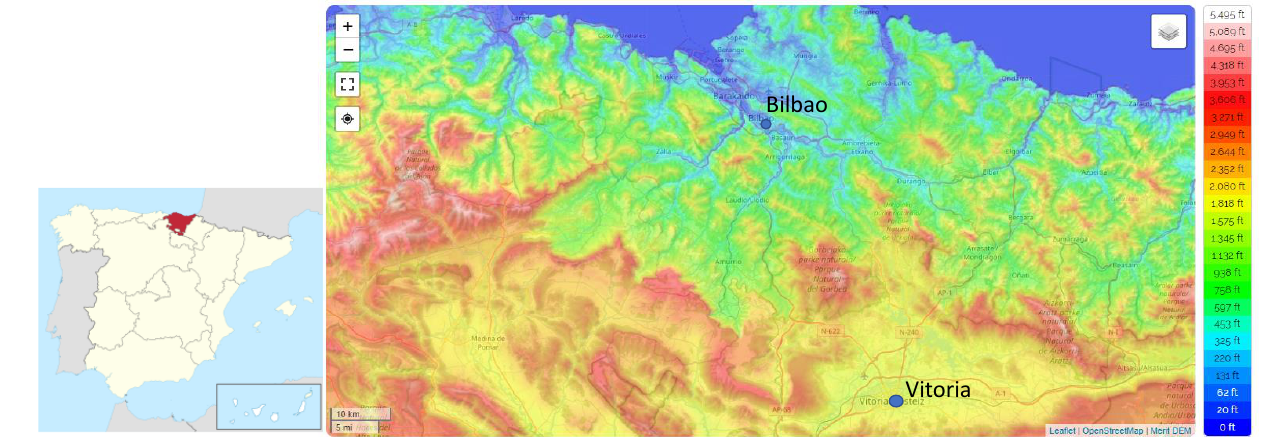
Figure 1. Location of the sampling site in the Basque country region (northern area of the Iberian Peninsula). Source: https://es-es.topographic-map.com/map-n3wtp/Península-ibérica/ (accessed on 14 October 2022).